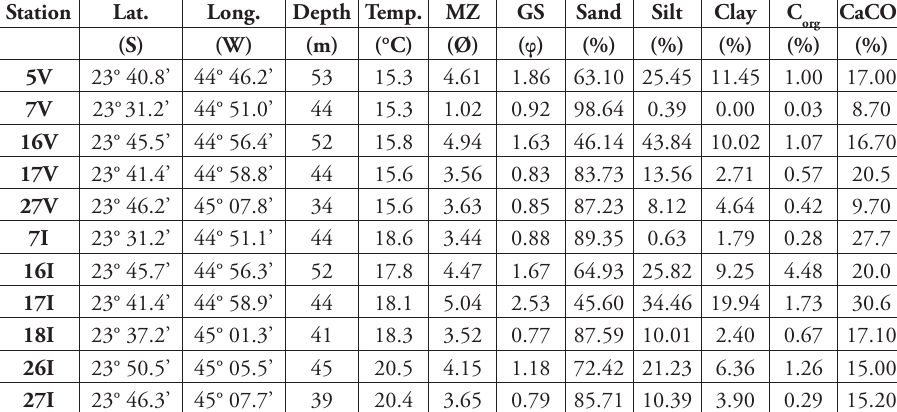
= organic carbon. org